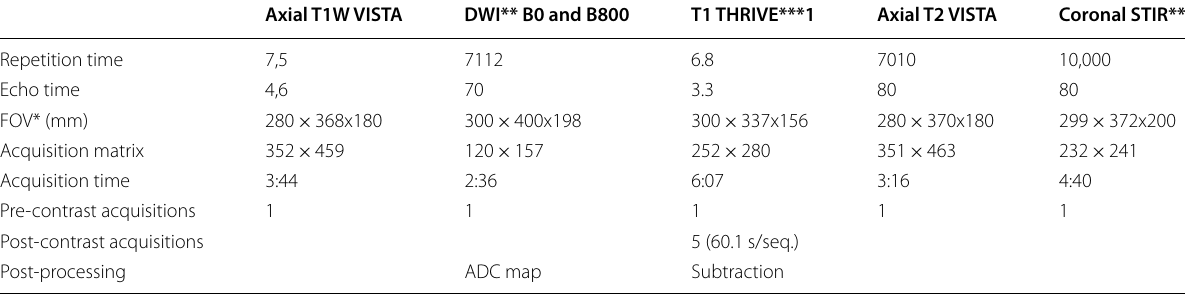
Table 1 Technical specifications of the breast magnetic resonance imaging protocol